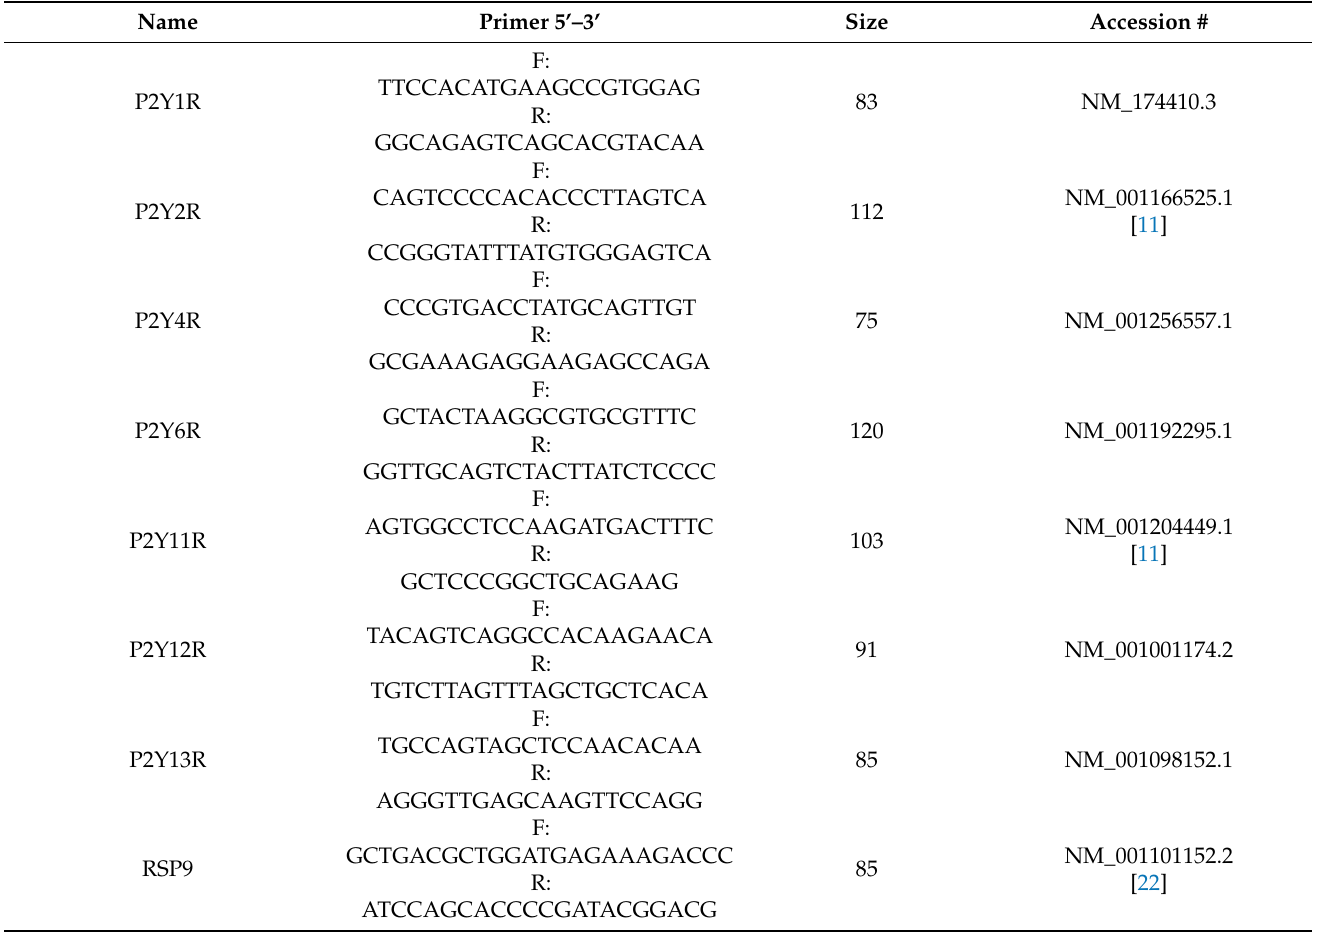
Table 1. Primers used in the RT-qPCR